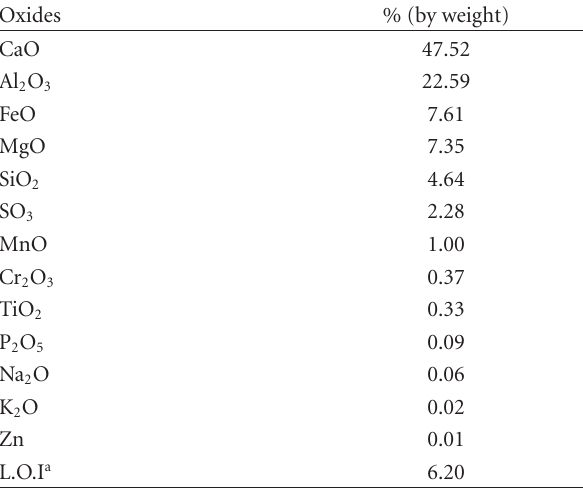
Table 5: Chemical composition of EAF(L) slag. Figure 5: X-ray di